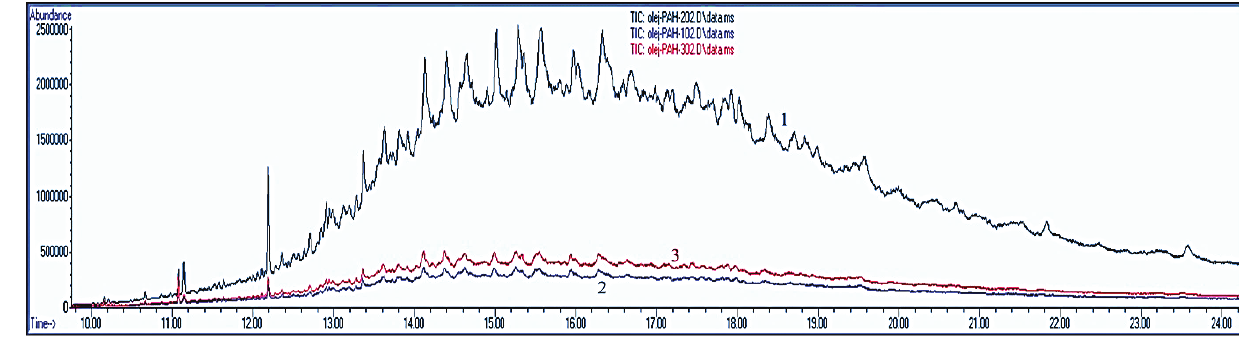
Fig. 1 – Chromatogram (Note: 1 – used oil, 2 – new oil, 3 – oil after regeneration, axis x – Time, axis y –